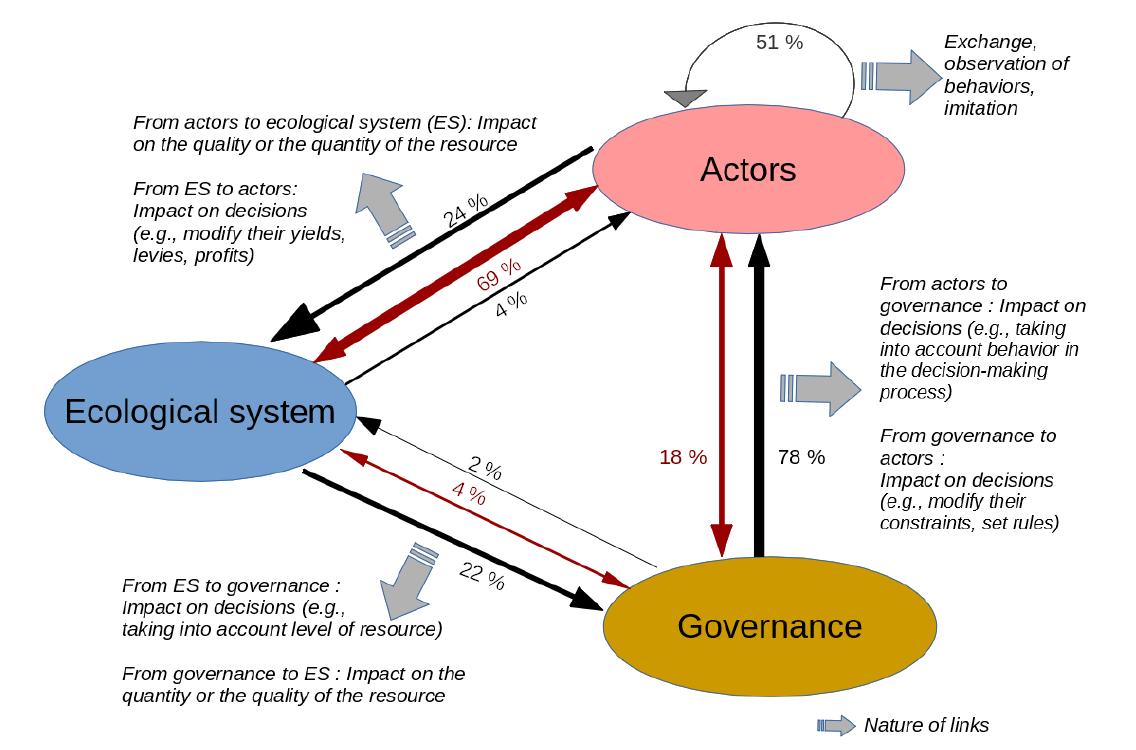
Fig. 3 . Types of links between sub-systems (percentage of